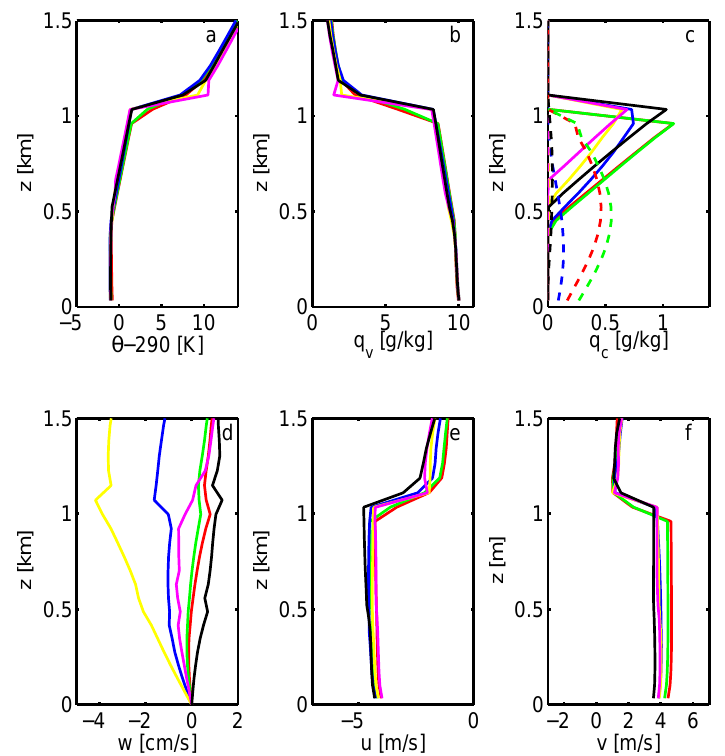
Fig. 12. Profiles of θ (a) , q v (b) , q c (c) , w (d) , u (e) , v (f) for P3 for times 04:00 (red), 04:30 (green), 05:00 (blue), 05:30 (yellow), 06:00 (magenta), 06:30 (black)